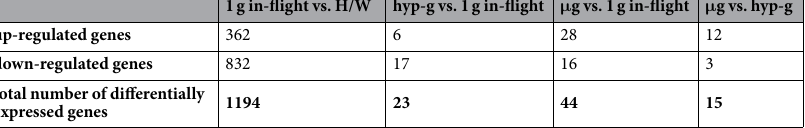
Table 2. Differentially expressed annotated genes in T cells during the 23 rd Parabolic Flight Campaign. Number of annotated genes that were significantly differentially expressed in the respective comparison. H/W: hardware samples, hyp-g: hypergravity samples, μ g: microgravity samples. Fold change ± 1.3, p < 0.05.